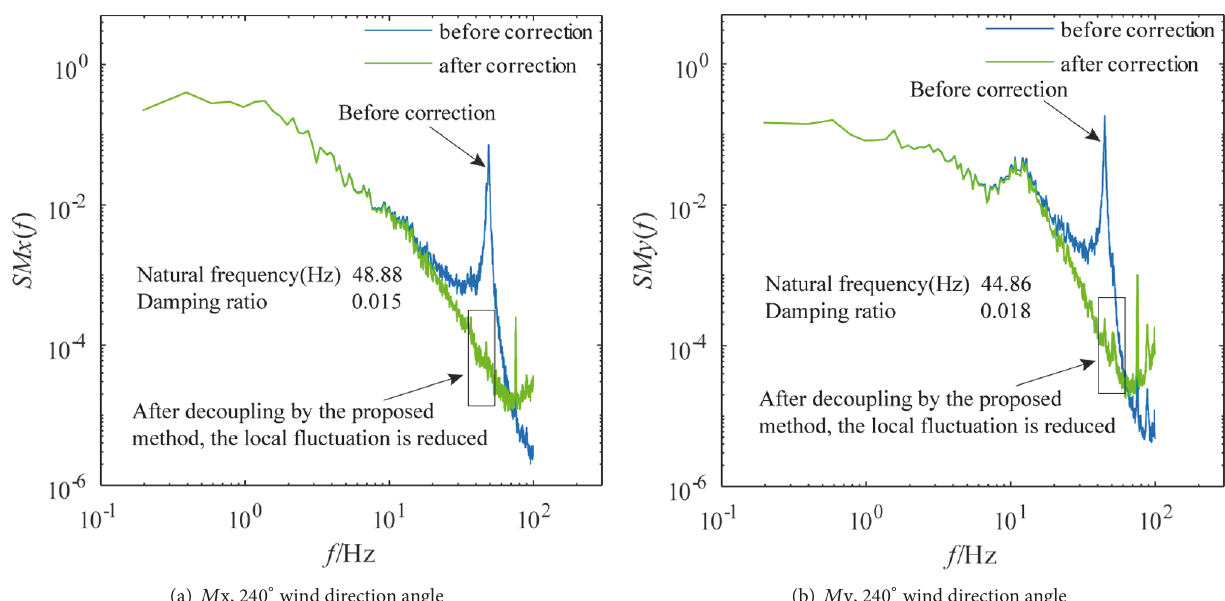
Figure 12: The correction effect of the base overturning moment of Guangzhou East Tower at 240 ∘ wind direction angle after decoupling.